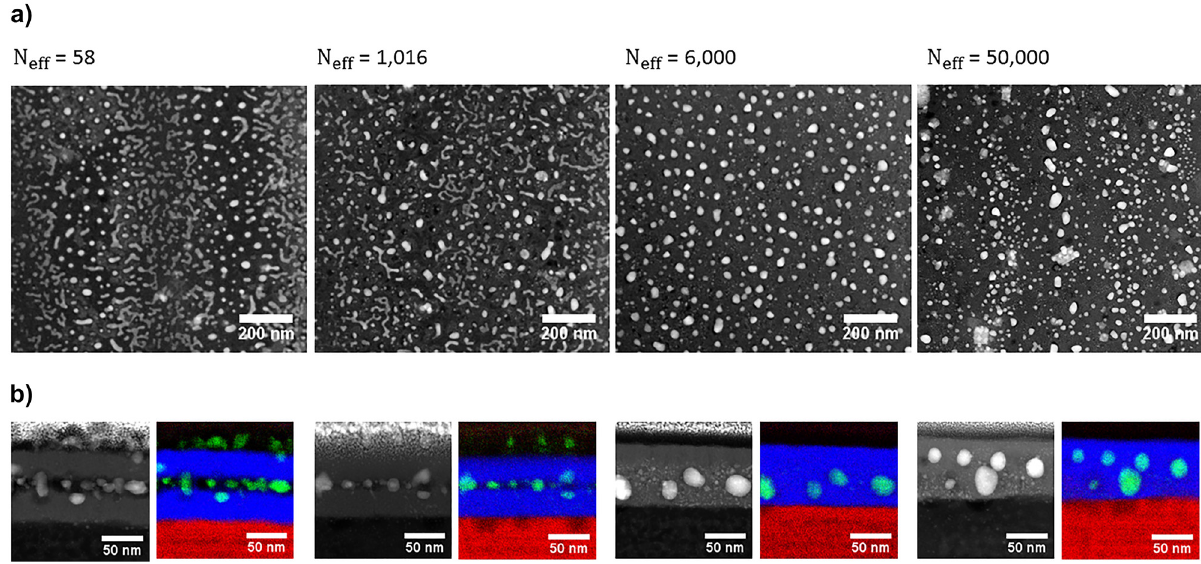
Figure 2: STEM characterizations of the center of laser-written lines for N eff = 58, 1016, 6000, and 50,000. (a) Plane-view HAADF-STEM images and (b) HAADF-STEM images of the corresponding cross-sections and EDS chemical mappings indicating Ag (green), Ti (blue), and Si